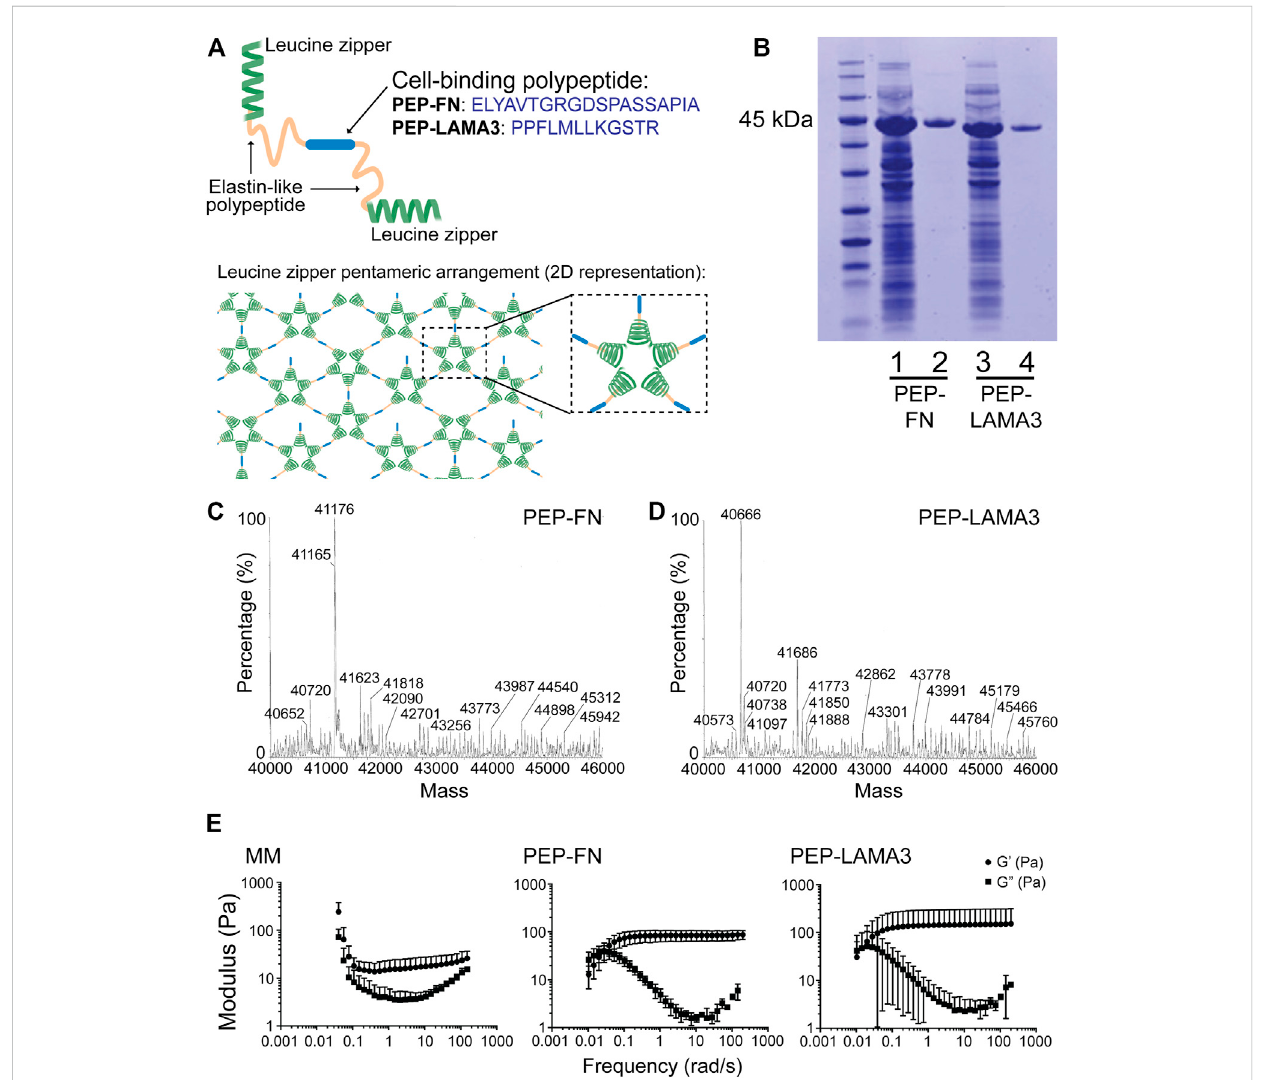
FIGURE 1 Construction and characterization of PEP-FN and PEP-LAMA3 hydrogels. (A) Schematic drawings of PEP-FN and PEP-LAMA3 proteins, which contain the following main elements: 1) leucine zipper (green) from rat cartilage oligomeric matrix protein which forms bundles (pentamers) in solution, leading to a physically cross-linked gel, 2) elastin-like polypeptides (yellow), and 3) the cell binding peptide (blue; either the fi bronectin RGD-containing peptide, or laminin three alpha mimetic), which is at the center of the protein. (B) SDS-PAGE gel stained with Coomassie InstantBlue on cell lysate priortopuri fi cation(lanes1and3)orafterpuri fi cation(lanes2and4). (C,D) ESI-TOFofbothproteinsshowingthattheproteinproductsareatthecorrect molecular weights (~41 kDa) (E) Rheological characterization of Matrigel-methylcellulose, PEP-FN, and PEP-LAMA3 media, as used in experimental